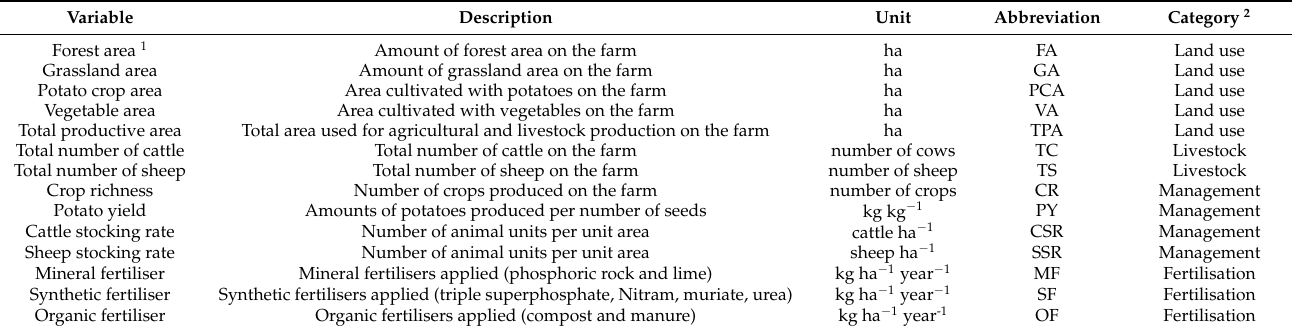
Table 1. Variables analysed for the agricultural system